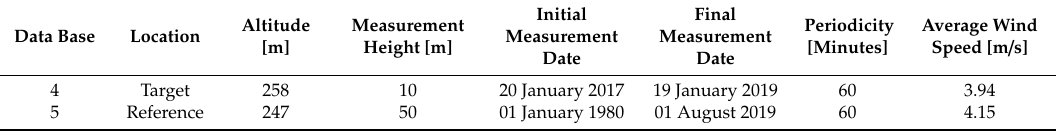
Table A1. Characterization of the databases of a second target location and the MERRA reanalysis used as the reference location